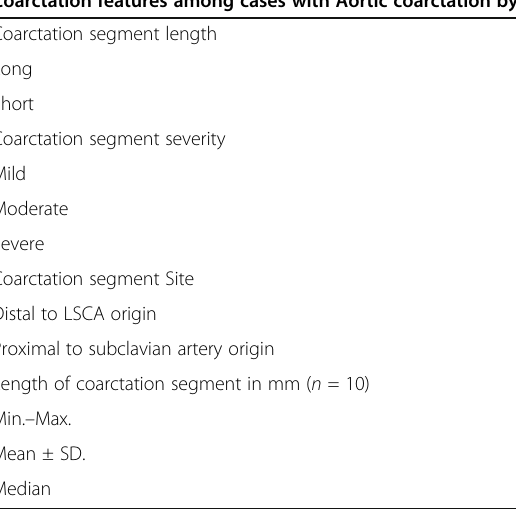
Table 3 Coarctation features detected by MDCT Coarctation features among cases with Aortic coarctation by MDCT No.